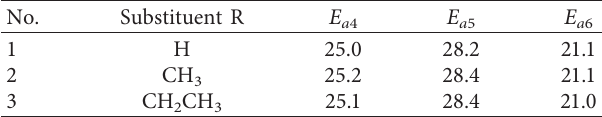
Figure 5: PES of the esterification between CA and methanol in parched condition. Table 1: Energy barrier of ring opening step in relation to the substituent R , which owns the +I effect in R-CH 2